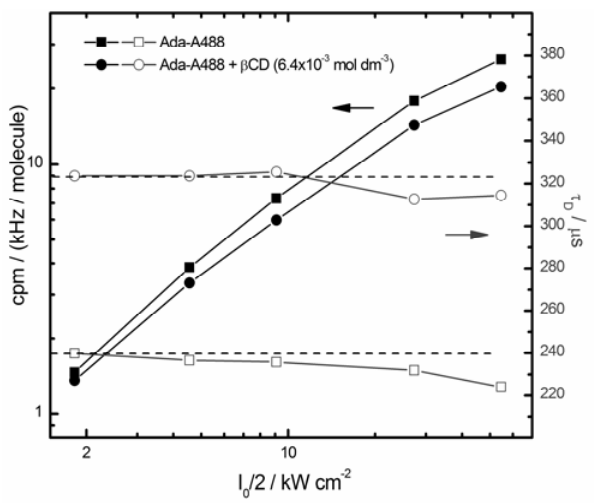
Figure 3. Power series of the FCS signal of Ada-A488 in aqueous solution (squares, [ β CD] = 0 mol dm -3 ) and at high concentration of β CD (circles, 0 [ β CD] = 6.4 × 10 -3 mol dm -3 ). [Ada-A488] ≈ 10 -9 mol dm -3 ). Left scale, filled symbols: 0 count rate per single Ada-A488 molecule. Right scale, open symbols: diffusion time of Ada-A488. All data obtained from FCS correlation curves similar to those shown in Figure 4 at different excitation irradiances. Counts per molecule (cpm) is the total detected fluorescence count rate divided by the mean number of molecules in the focus N